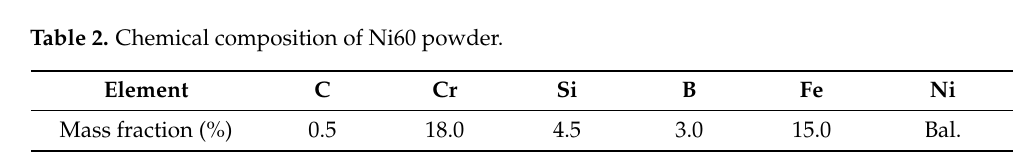
Table 2. Chemical composition of Ni60 powder.